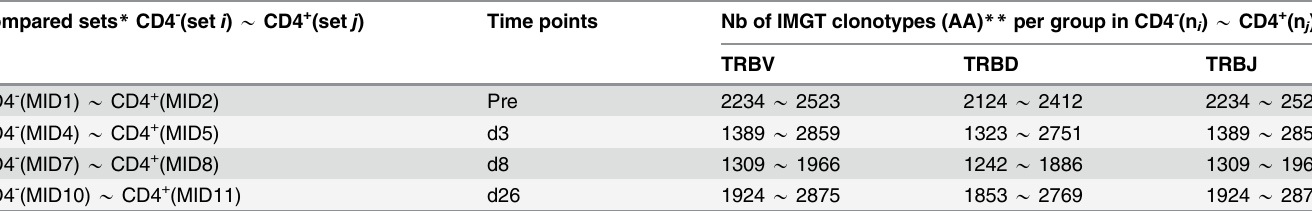
Table 1. Number (nb) of in-frame Homo sapiens TRB IMGT clonotypes (AA) per group in CD4 - versus ( * ) CD4 + populations at four time points. Compared sets * CD4 - (set i ) * CD4 + (set j